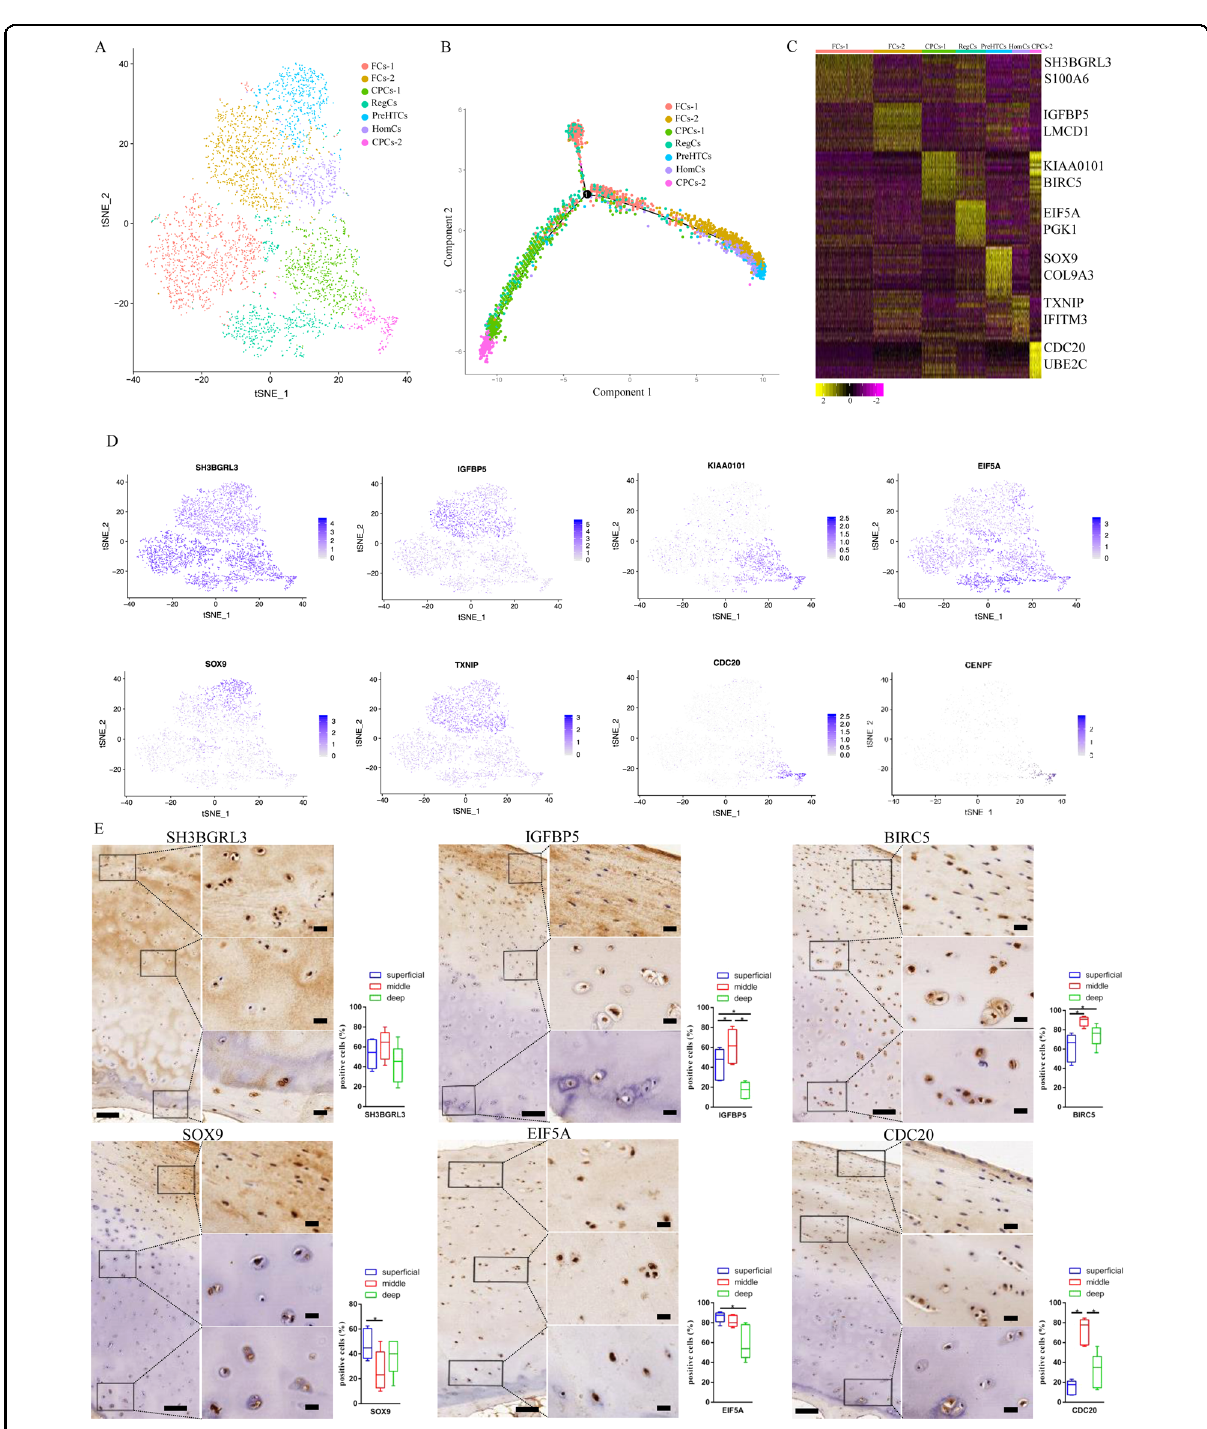
Fig. 1 Single-cell RNA-sequencing analysis of human healthy control chondrocyte tissue samples. A Seven healthy human chondrocyte clusters. Visualisation of clustering by t-SNE plot of healthy control samples, identi fi ed by cell type. B Monocle pseudotime trajectory showing the progression of seven clusters of healthy chondrocytes. C Heat map of scaled gene expression data for the top 10 differentially expressed genes identifying each cluster, with selected genes listed. D Gene expression plots demonstrating high expression of SH3BGRL3 in SH3BGRL3 hi fi brocartilage chondrocytes- 1, IGFBP5 in IGFBP5 hi fi brocartilage chondrocytes-2, CDC20 in CDC20 hi cartilage progenitor cells-1, KIAA0101 in KIAA0101 hi cartilage progenitor cells-2, EIF5A in EIF5A hi regulatory chondrocytes, SOX9 in SOX9 hi prehypertrophic chondrocytes and TXNIP in TXNIP hi homeostatic chondrocytes. Dot colour corresponds to the level of gene expression in each cell. t-SNE, t-distributed stochastic neighbour embedding. E Representative immunohistochemistry staining of SH3BGRL3, IGFBP5, BIRC5, SOX9, EIF5A and CDC20 in healthy cartilage tissues. Scale bar, left, 500 μ m; right, 50 μ m, and quanti fi cation of positive cells of different areas (super fi cial, middle, deep) in cartilage tissues displayed by box plot ( n = 5). * p